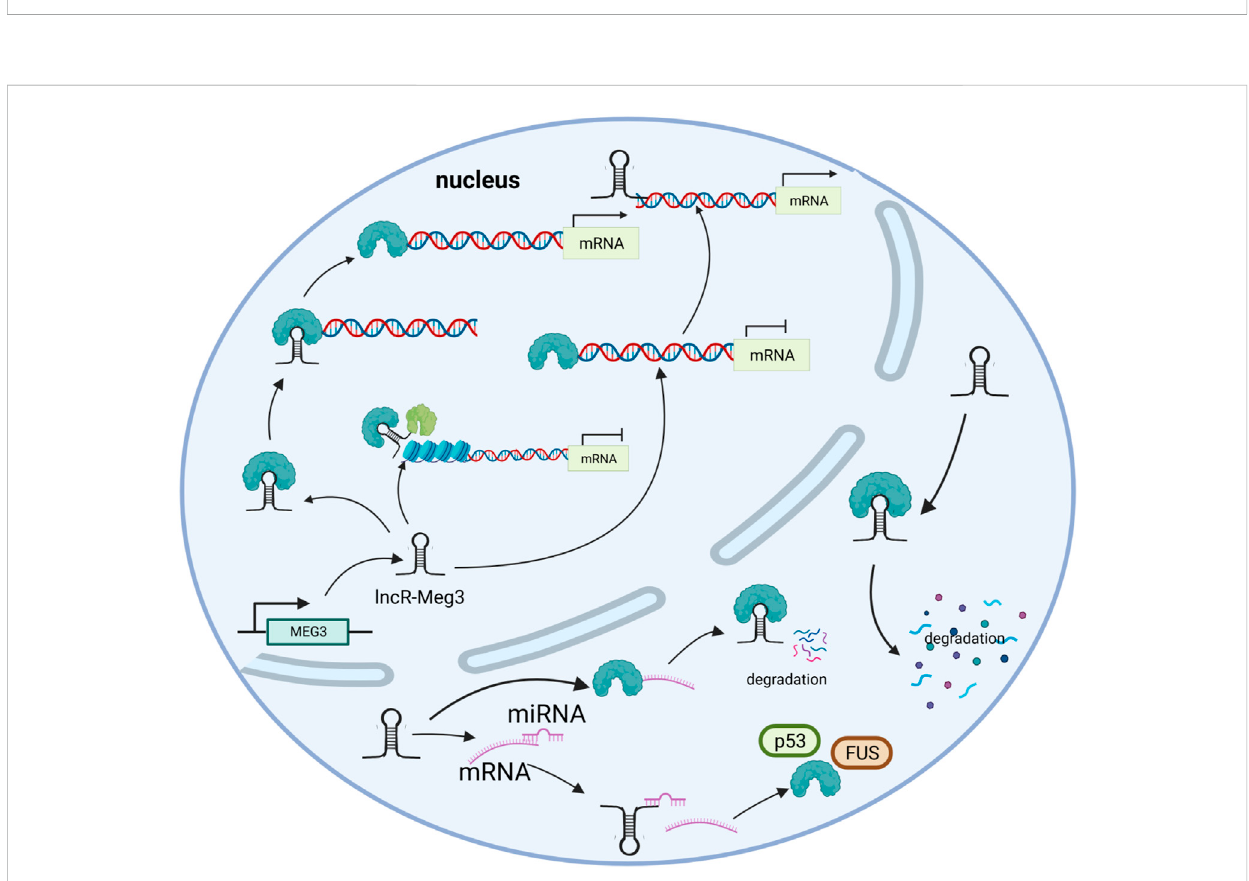
FIGURE 2 The mechanisms of lncR- Meg3. lncR- Meg3 acts as a molecular scaffold connecting different proteins and forming large complexes that regulate chromatin structure and gene expression. LncR- Meg3 competes to bind miRNAs and affects mRNA translation. LncR- Meg3 binds proteins, thereby promotes mRNA degradation and/or regulates gene